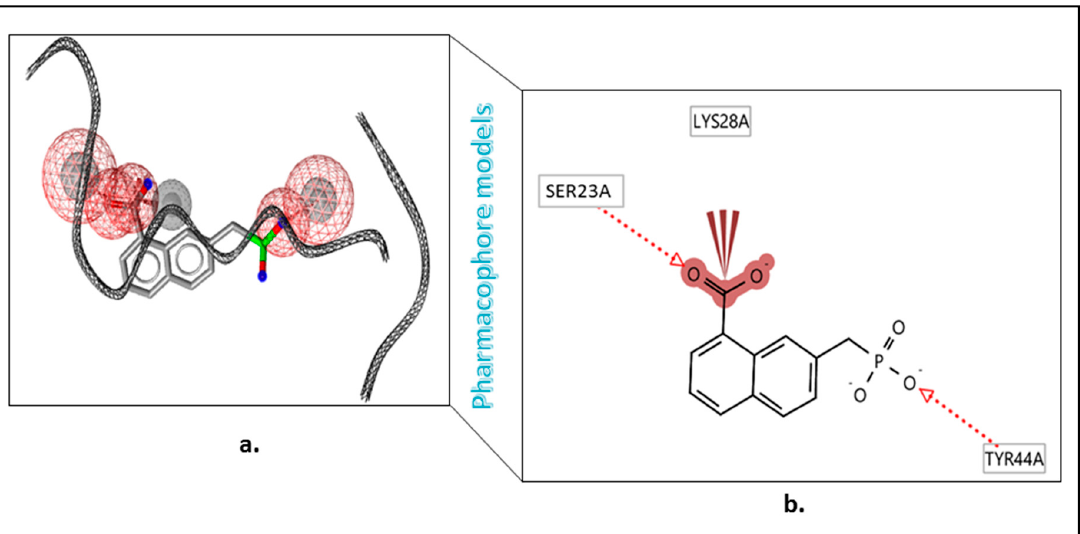
Figure 7. ( a ) Tau pharmacophore model aligned with most active compound-7 Phosphonomethyl- naphthalene-1-carboxylic acid (CHEMBL123495); ( b ) interactions between native ligand and target site amino acid residues with hydrophobic interactions shown as acceptor interactions in red.